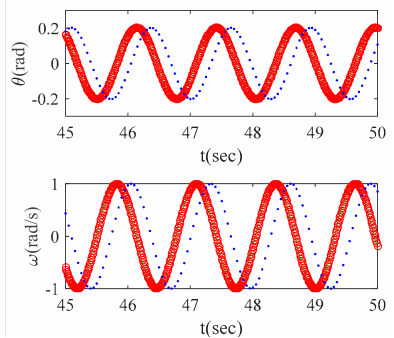
Figure 12. Simulation results with different time steps.